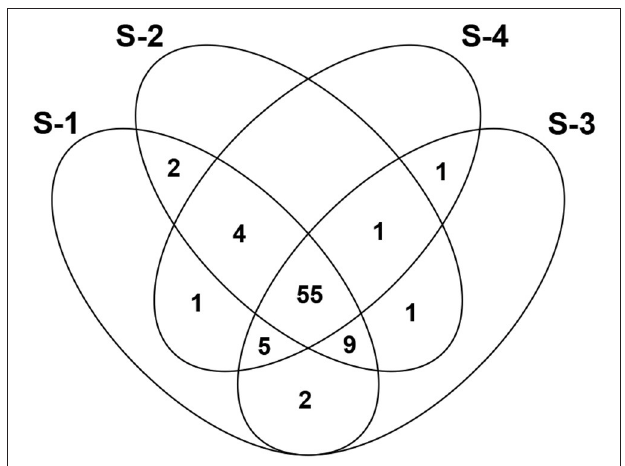
FIGURE 4 | Venn diagram showing aroma compounds common to the